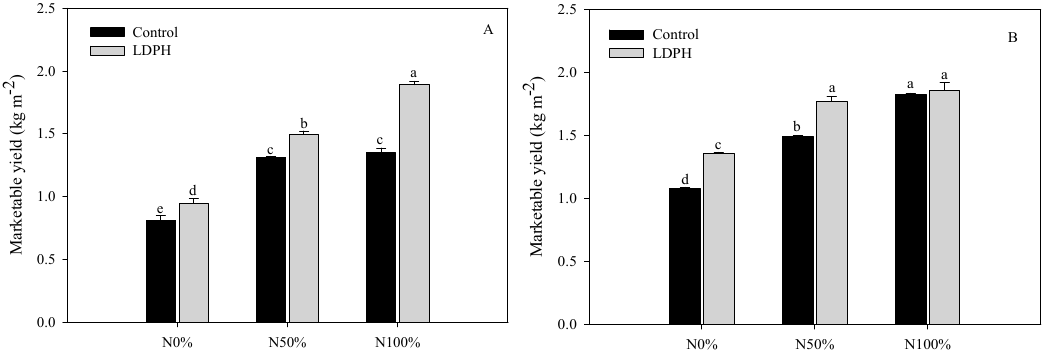
Figure 1. Marketable yield of baby spinach ( A ) and lamb’s lettuce plants ( B ) as affected by nitrogen (N) fertilization levels (0, 2.25 and 4.5 g N m − 2 and 0, 2.5 and 5.0 g N m − 2 ; N0%, N50%, N100%, respectively) and biostimulant application (non-treated control and LDPH: Legume-derived protein hydrolysates). Different letters indicate significant differences according to the DMR test ( p < 0.05). Vertical bars indicate ± standard error of means.